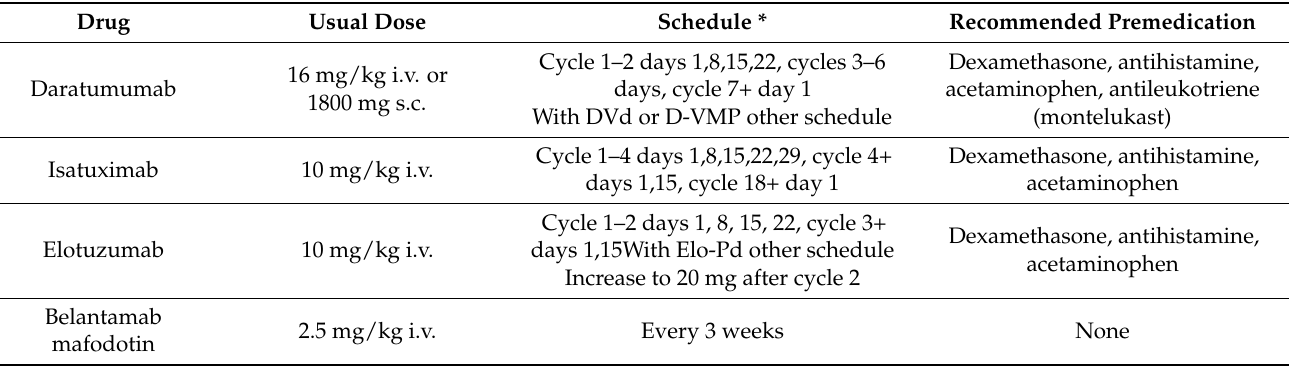
Table 1. Usual dosing of currently approved